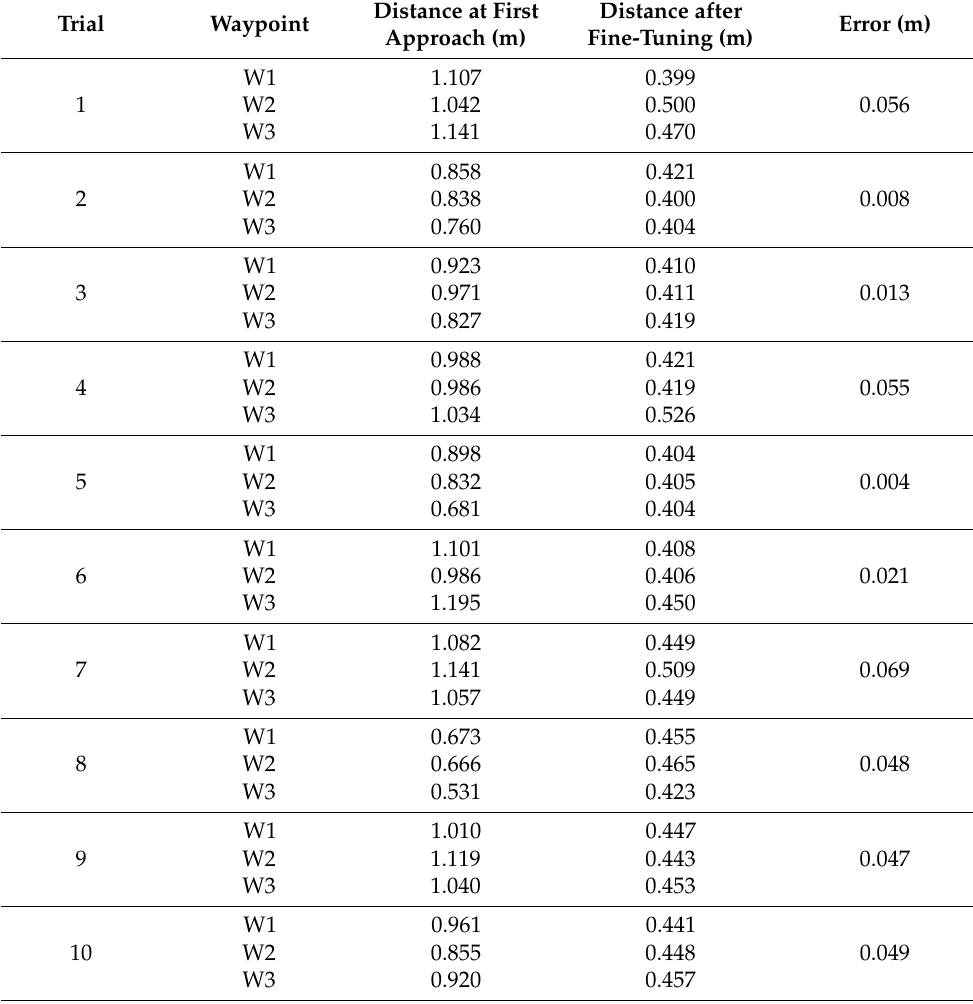
Table 4. Position errors measured during fine-tuned